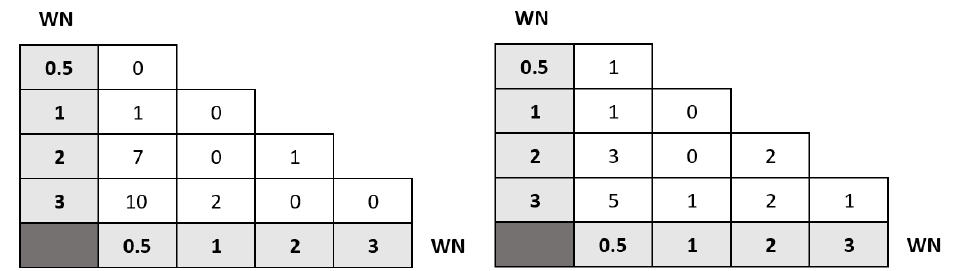
Figure 19. Damage detection ( left ) and damage diagnosis ( right ) number of failed predictions per WN combination for model 1. Rows are related to the true amplitude factor and columns to the predicted amplitude factor.